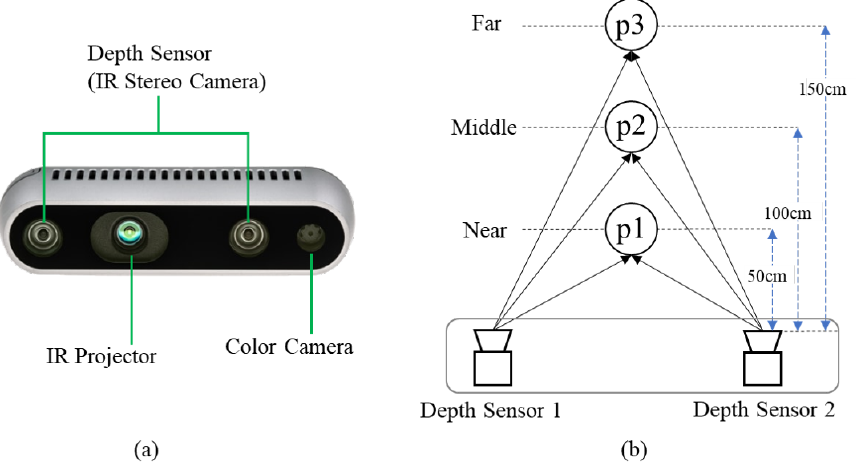
Figure 9. Experimental tools and settings: ( a ) Intel RealSense Depth Camera D435. ( b ) Experimental settings with three